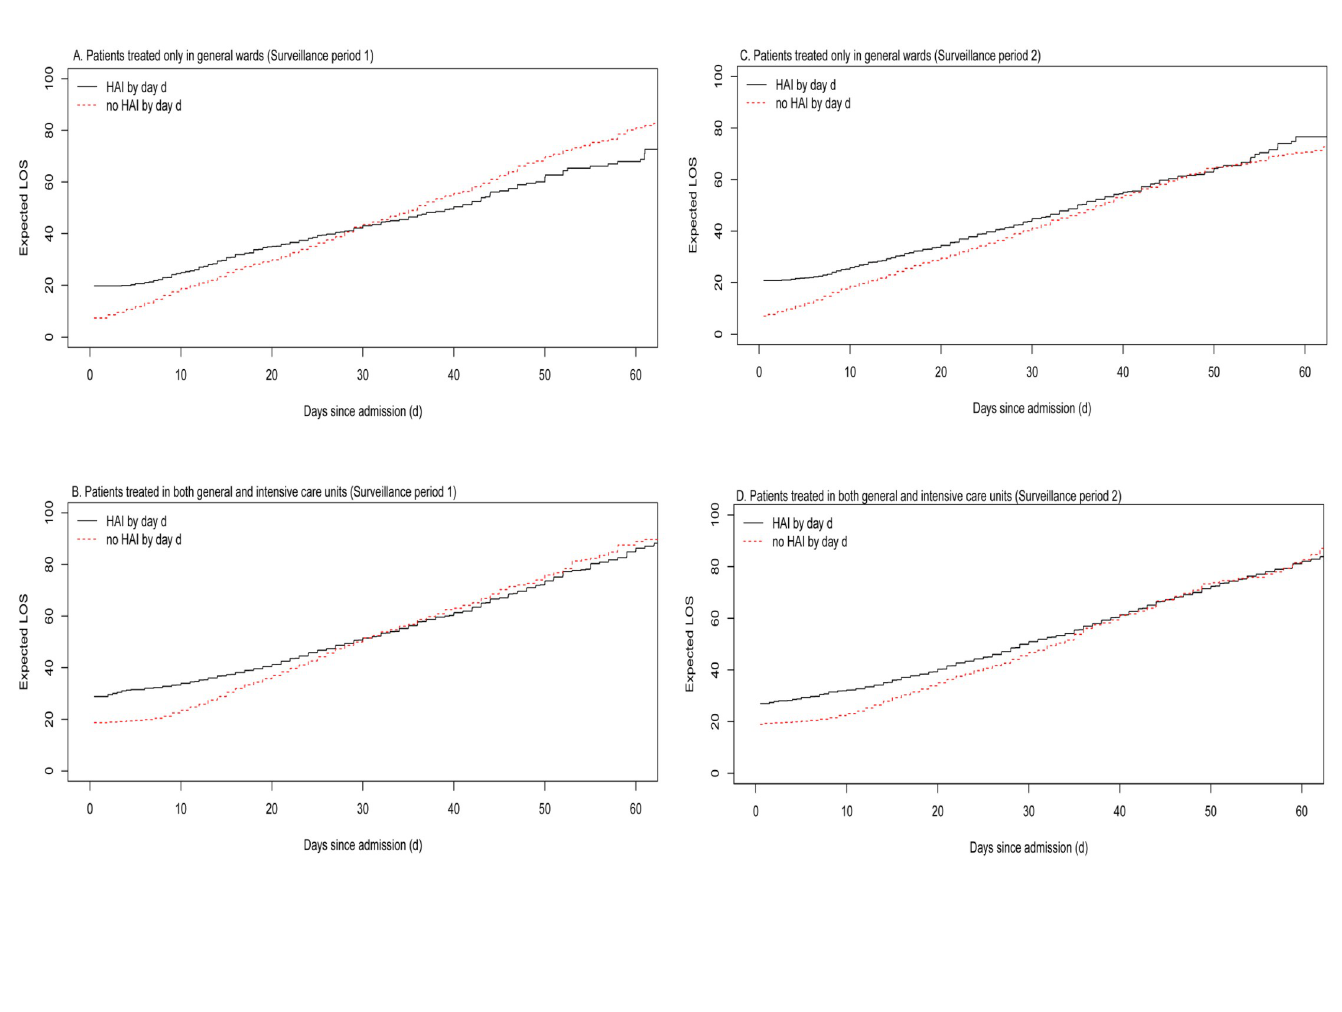
Fig 3. Results of multistate models to determine expected length of stay for patients with and without HAIs up to 60 days after admission.